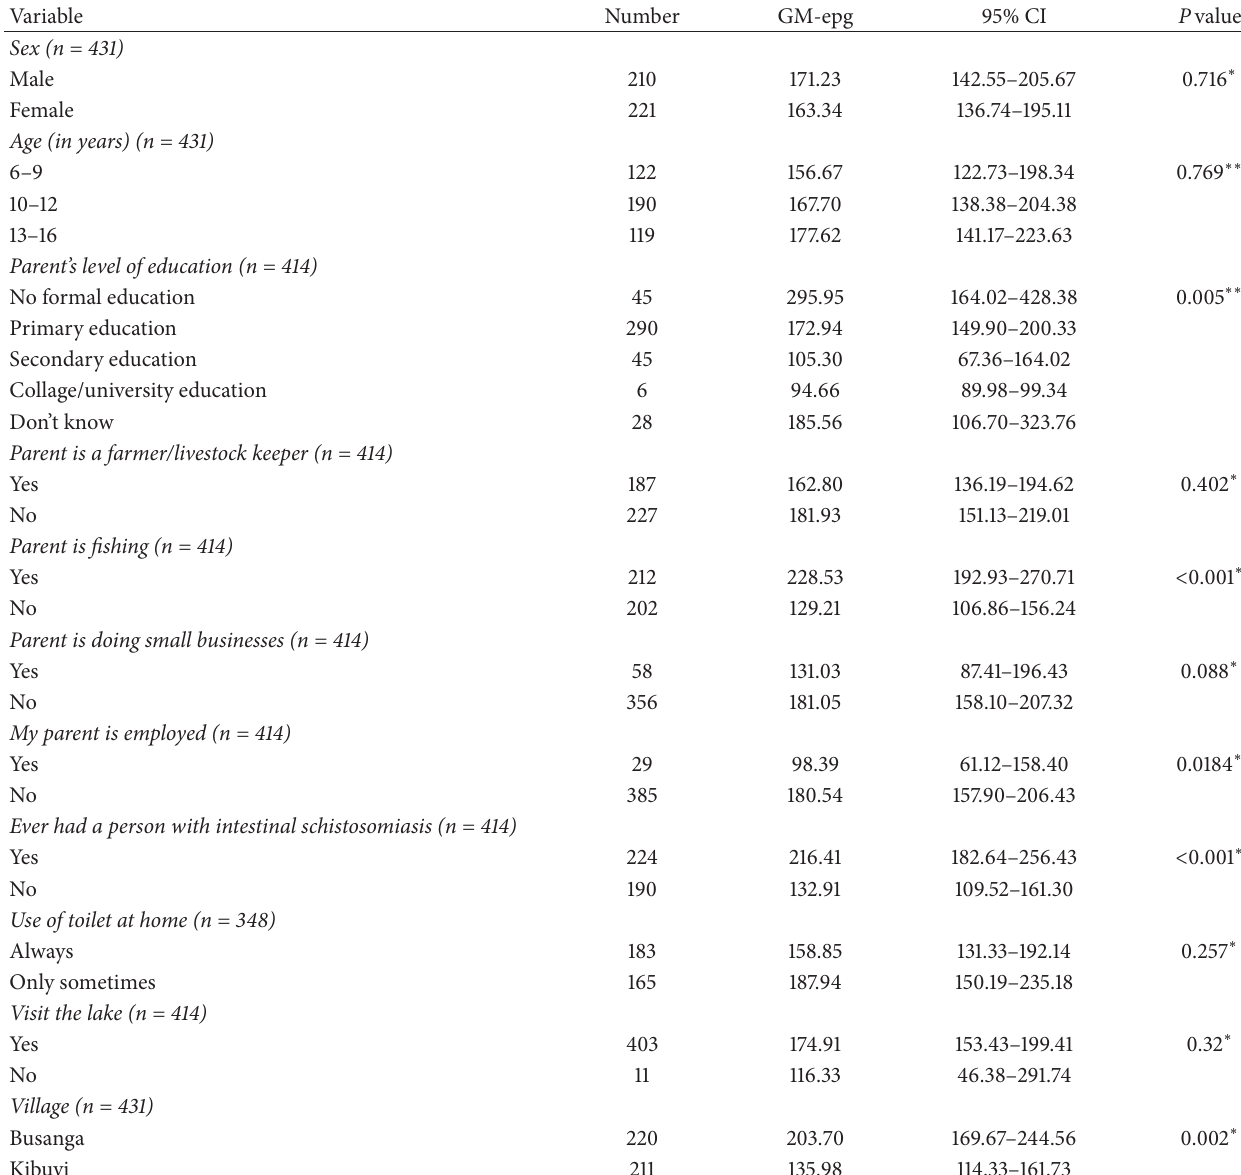
Table 2: Intensity of Schistosoma mansoni infection by sociodemographic characteristics among study